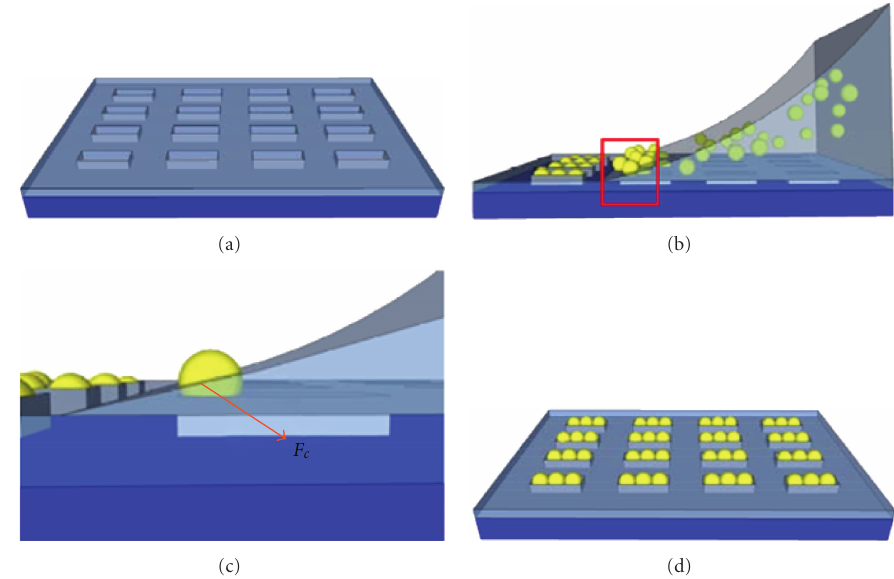
Figure 3: (a) Silicon substrate immediately after FIB milling of SiO 2 layer. (b) Illustration of three-phase contact line dragging nanoparticles across the substrate surface. (c) Close-up illustration of particles pushed into milled trenches via the capillary force. (d) Array of nanosphere trimers after deposition is complete.